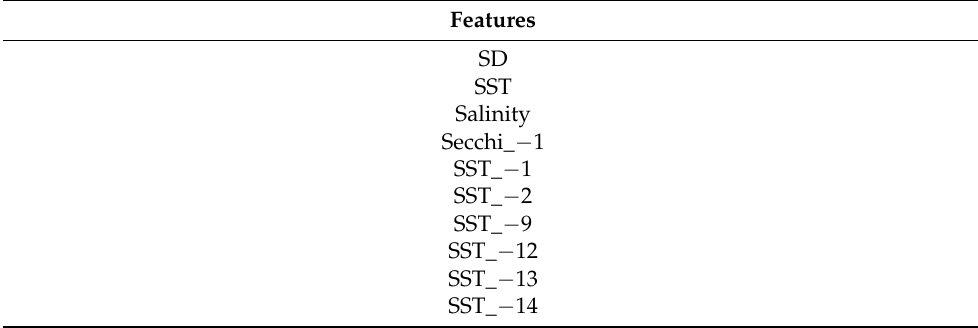
Figure 3. Result of RFECV with Ridge estimator. The black dot represents the maximum value of 17 selected features (predictors) to reach the highest explained variance. After the maximum value, there is an exponential decay/increase in the R 2 /RMSE. RMSE unit is µ g L − 1 . Table 3. Chosen features after Feature Selection process. The negative numbers represent the number of lags in the original features (t − 1, . . . , t −